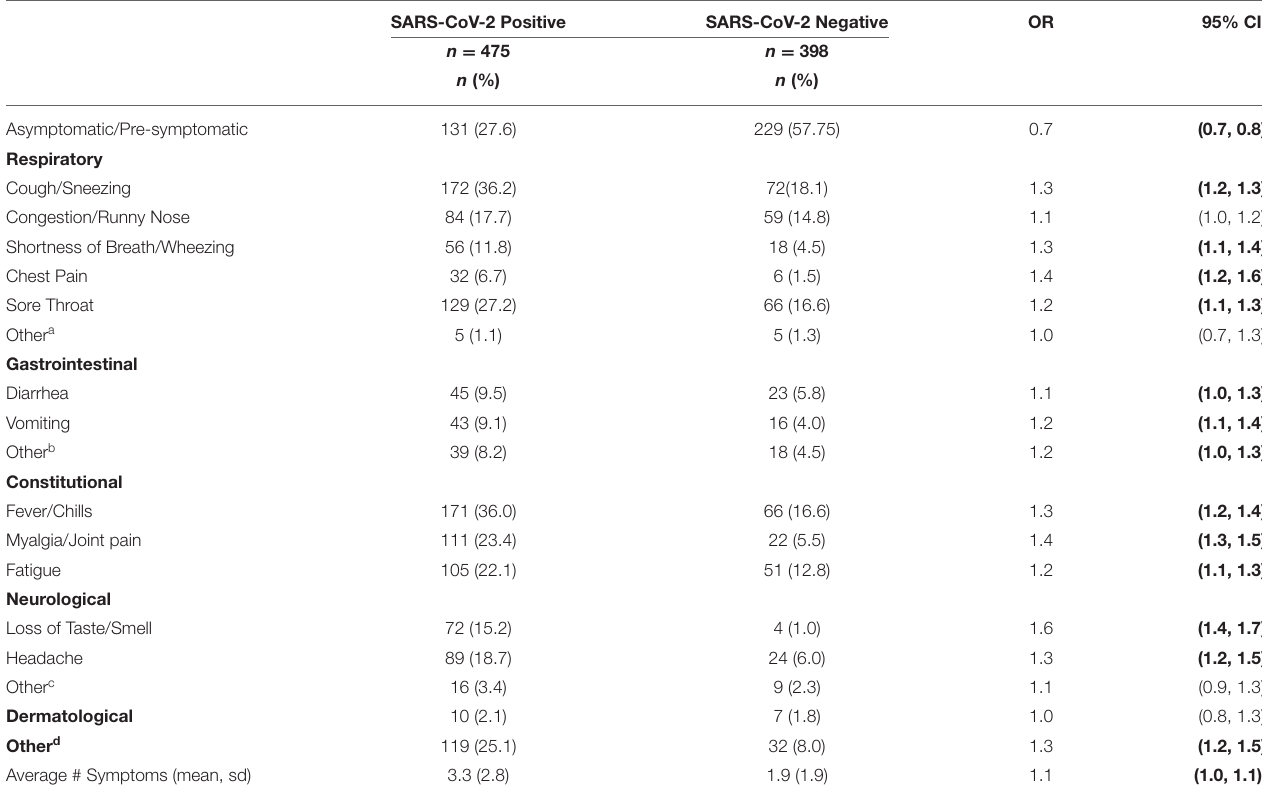
TABLE 4 | Symptoms at time of SARS-CoV-2